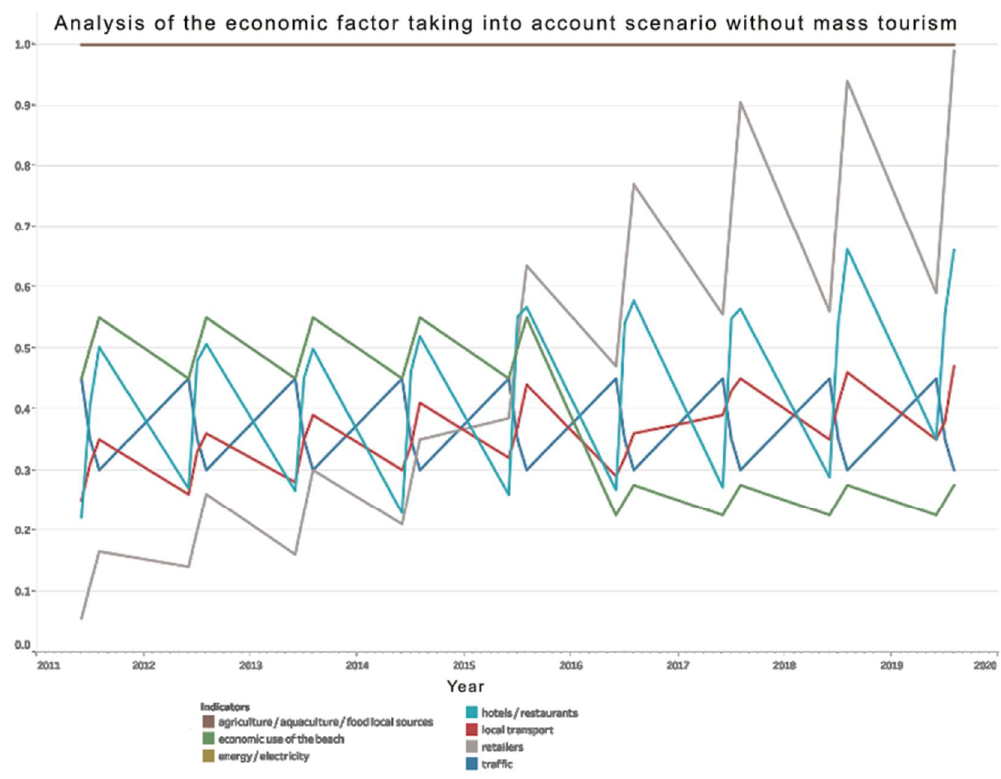
Figure 7. Analysis of economic factor indicators for the without mass tourism scenario.